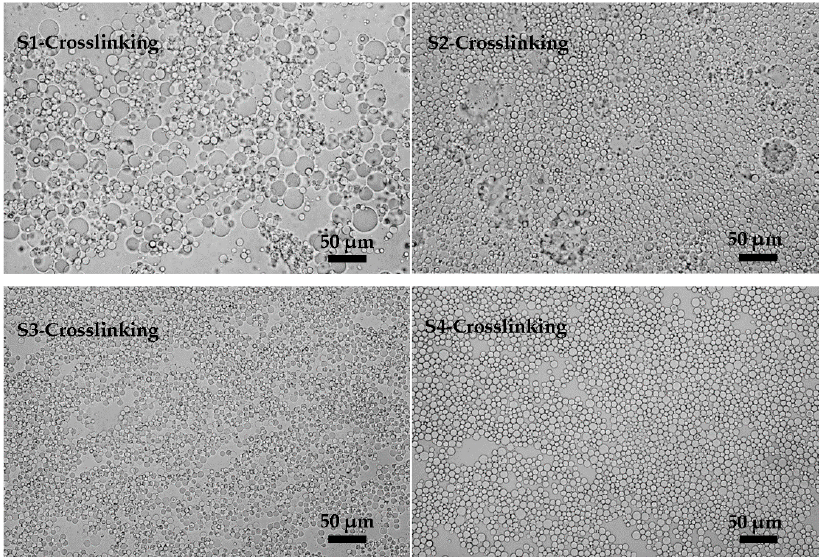
Figure 4. Microscopic photographs of KGM microspheres prepared with different emulsifier concentrations (3%, 4%, 5% and 6%, Po-5S, w / w ): S1-Crosslinking, S2-Crosslinking, S3-Crosslinking and S4-Crosslinking were the crosslinking results of S1 , S2 , S3 and S4 .